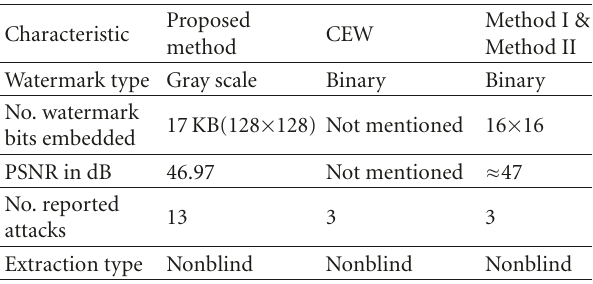
Table 7: Comparison of the proposed method with similar domain